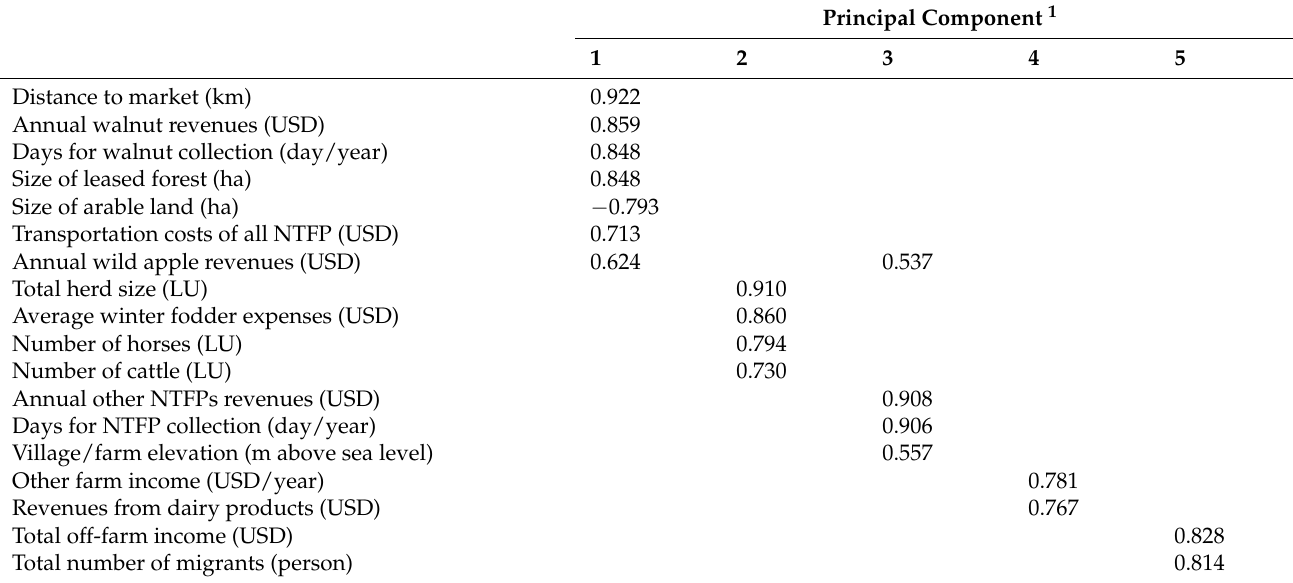
Table 2. Loading variables in the selected principal